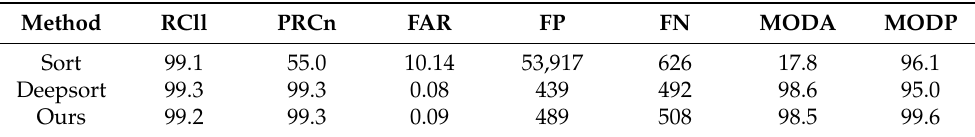
Table 9. Comparison of tracking metrics on MOT17Det dataset and deepsort